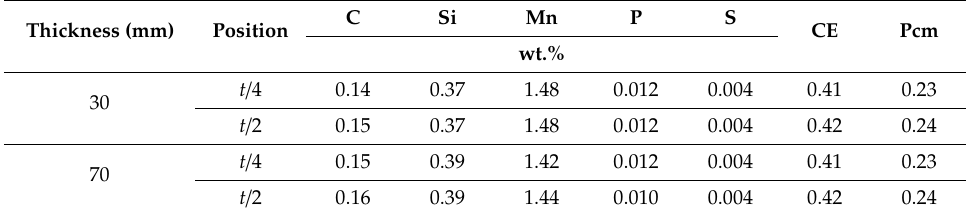
Table 4. Chemical composition, carbon equivalent (CE), and weld cracking parameter (Pcm) depending on thickness and positions of the SN 490C plates.